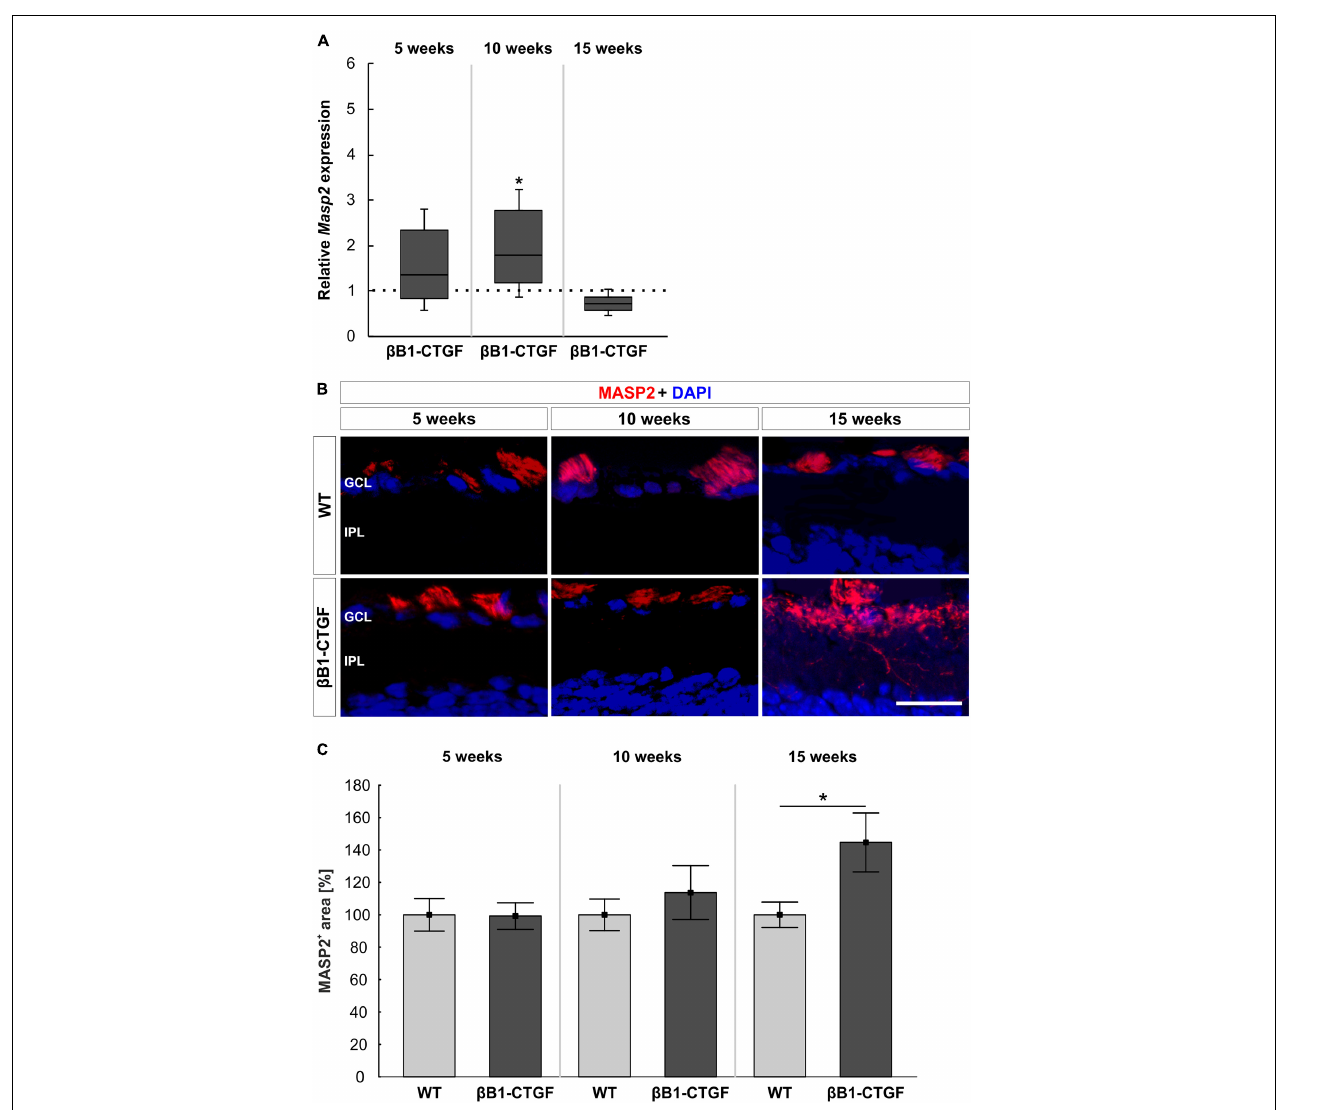
FIGURE 5 | Lectin pathway is initiated. (A) The mRNA expression levels of Masp2 were upregulated at 10 ( p = 0.047), but not at 5 and 15 weeks, in β B1-CTGF mice. (B) An anti-MASP2 antibody (red) was used to label retinal cross-sections at 5, 10, and 15 weeks of age. Cell nuclei are counterstained with DAPI (blue). (C) The MASP2 + area was not altered in transgenic mice compared to WT at 5 and 10 weeks. At 15 weeks, a significant increase of MASP2 + area was revealed in β B1-CTGF animals ( p = 0.04). Values for RT-qPCR are median ± quartile ± minimum/maximum ( n = 5–7/group). The dotted line in panel (A) represents the relative expression of the WT group. Values for immunohistology are mean ± SEM ( n = 7–9/group). GCL, ganglion cell layer; IPL, inner plexiform layer. Scale bar: 20 µ m. * p <